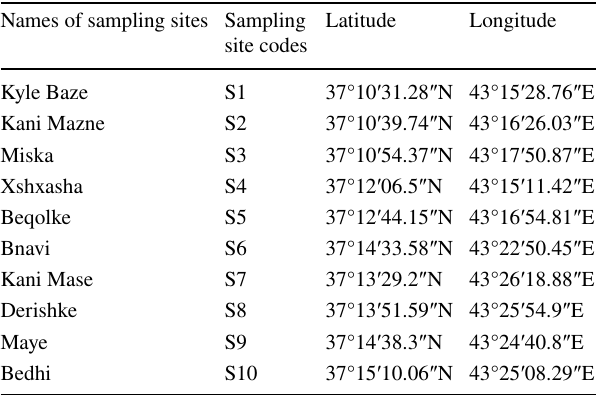
Table 1 The name and geographic coordinates of the sample springs Names of sampling sites Sampling Latitude site codes